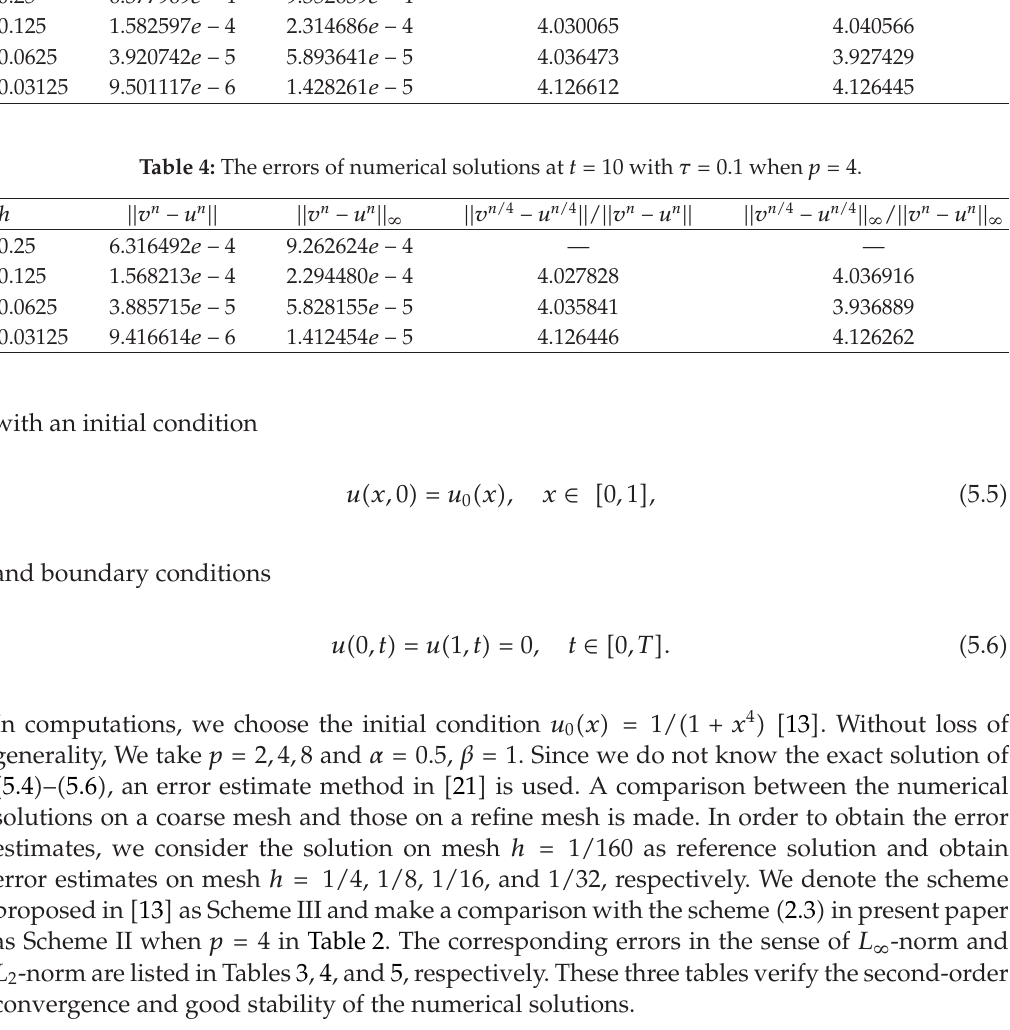
Table 3: The errors of numerical solutions at t (cid:9) 10 with τ (cid:9) 0 . 1 when p (cid:9) 2. h